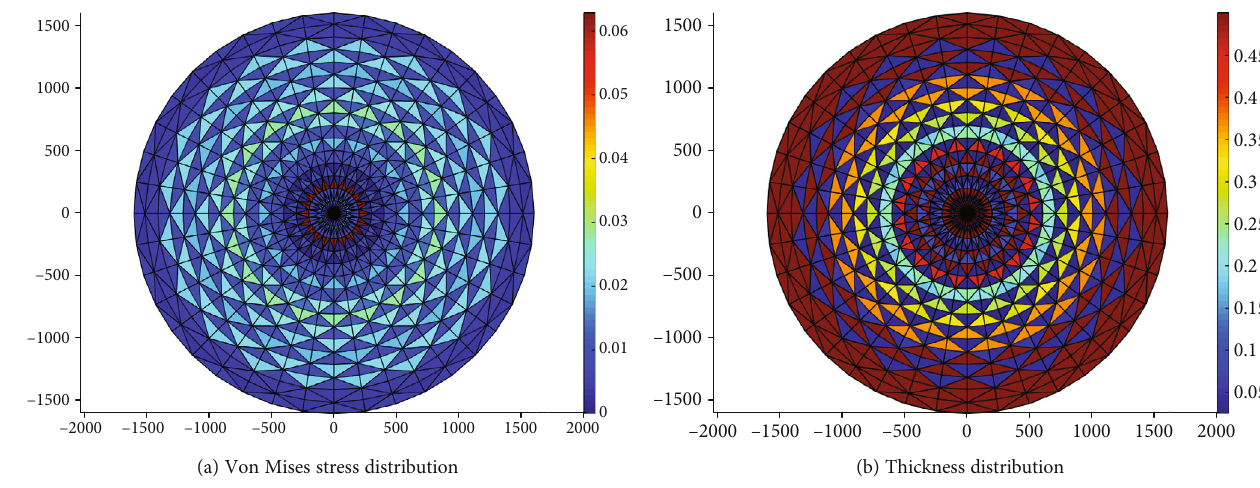
Figure 5: Stress and thickness distribution of optimal re fl ector by the HPL-E Method. Table 3: Result summary of the BFP-E Method by di ff erent parameter r . min